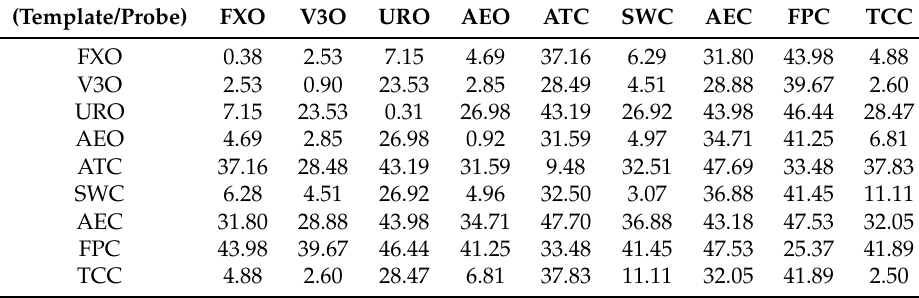
Table 5. EER (%) produced by the MCC